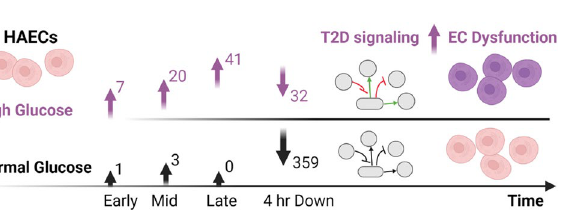
Figure 7. Schematic summary. Unique number of DEGs in each K-means cluster in NG/HG conditions and the resultant downstream effects. Number of unique DEGs are shown in the early, middle, late or 4 h downregulated K-means cluster. The DEGs unique to HG conditions result in activation of pathways that lead to EC dysfunction. The genes associated with the pathways identified from the K-means clusters are listed in supplementary Tables S10 and S11. Figure created with